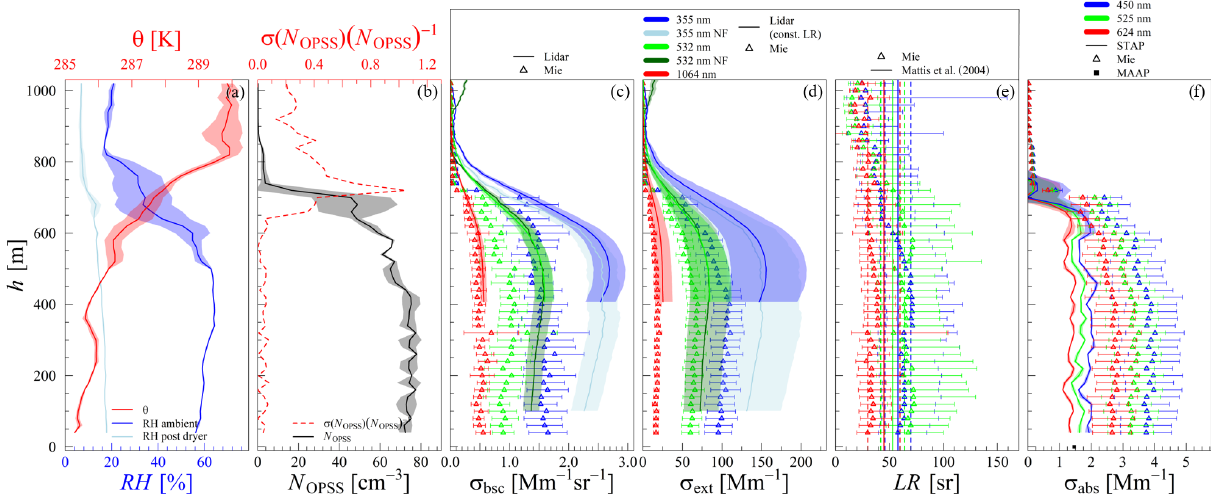
Figure 8. Corresponding to Fig. 7 for the period 13:30–14:09UTC on 9 March.